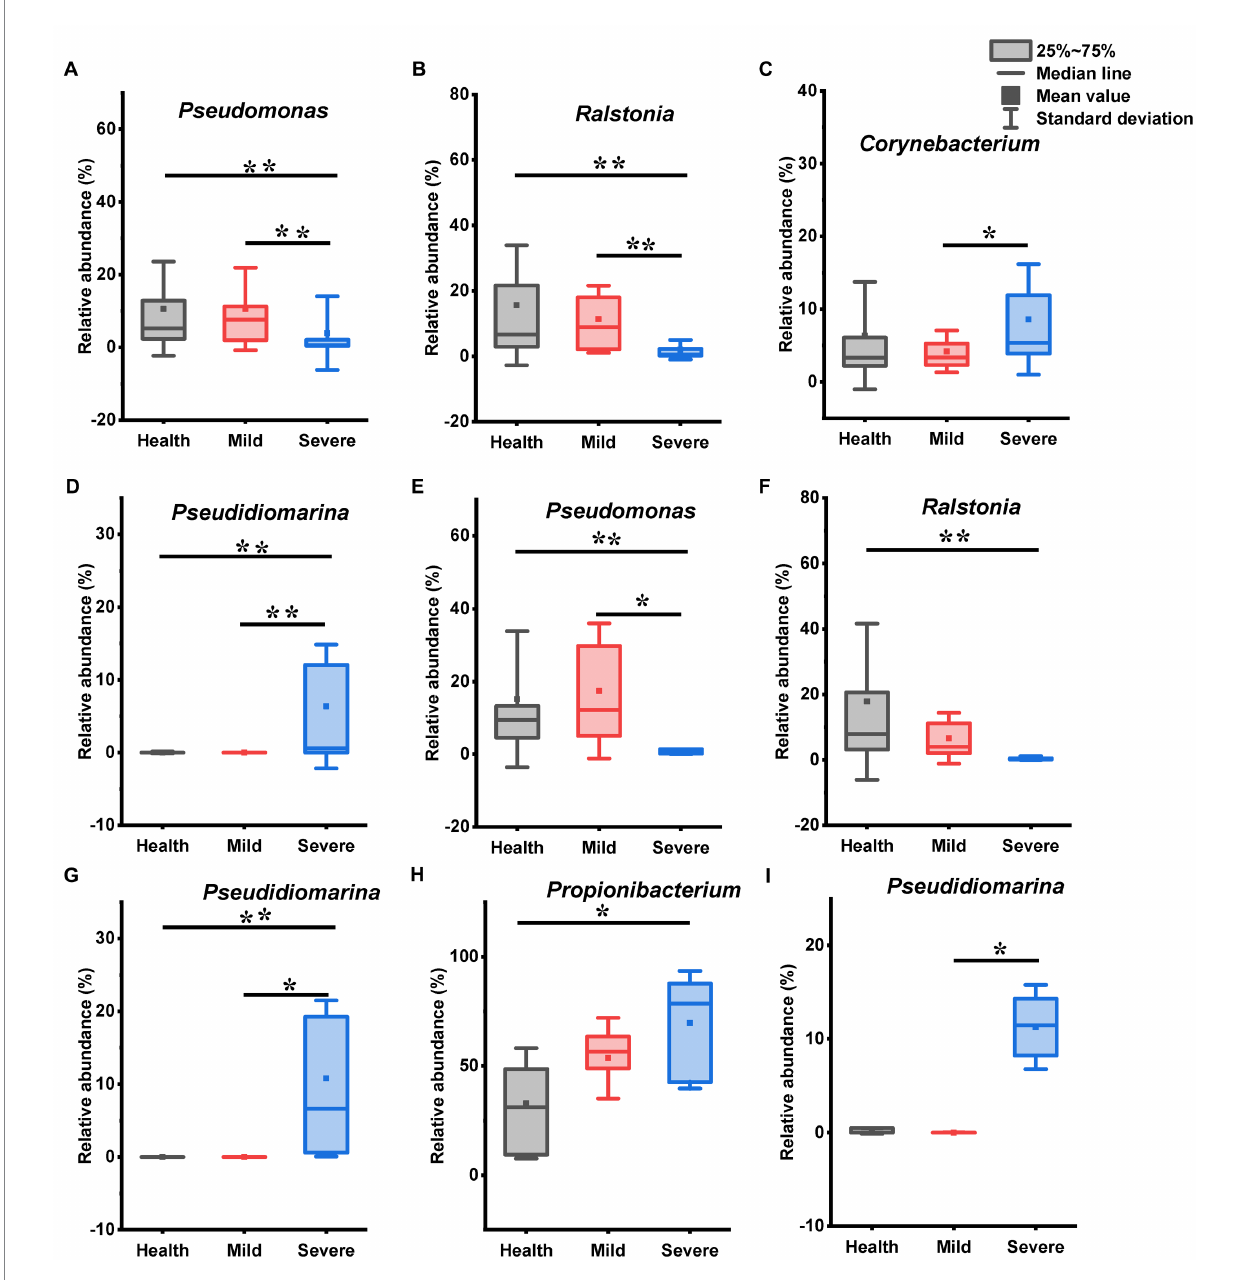
FIGURE 3 The genus with statistical difference between groups in the bacteria flora. (A–D) Samples from all sites; (E–G) samples from cheek; (H) samples from chin; (I) samples from chest and back. *0.01 < p < 0.05, significant difference; ** p < 0.01, highly significant